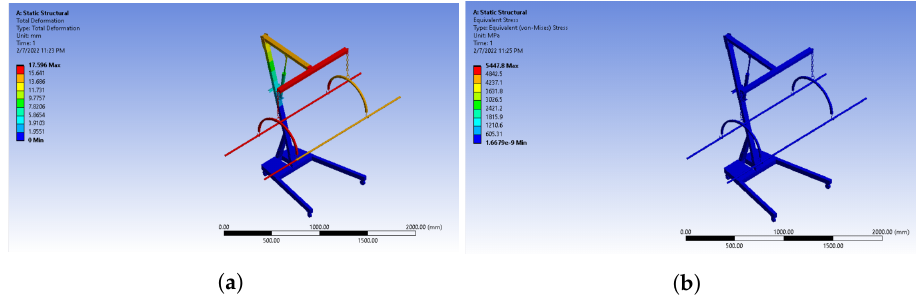
Figure 13. ( a ) Equivalent stress and ( b ) total deformation using